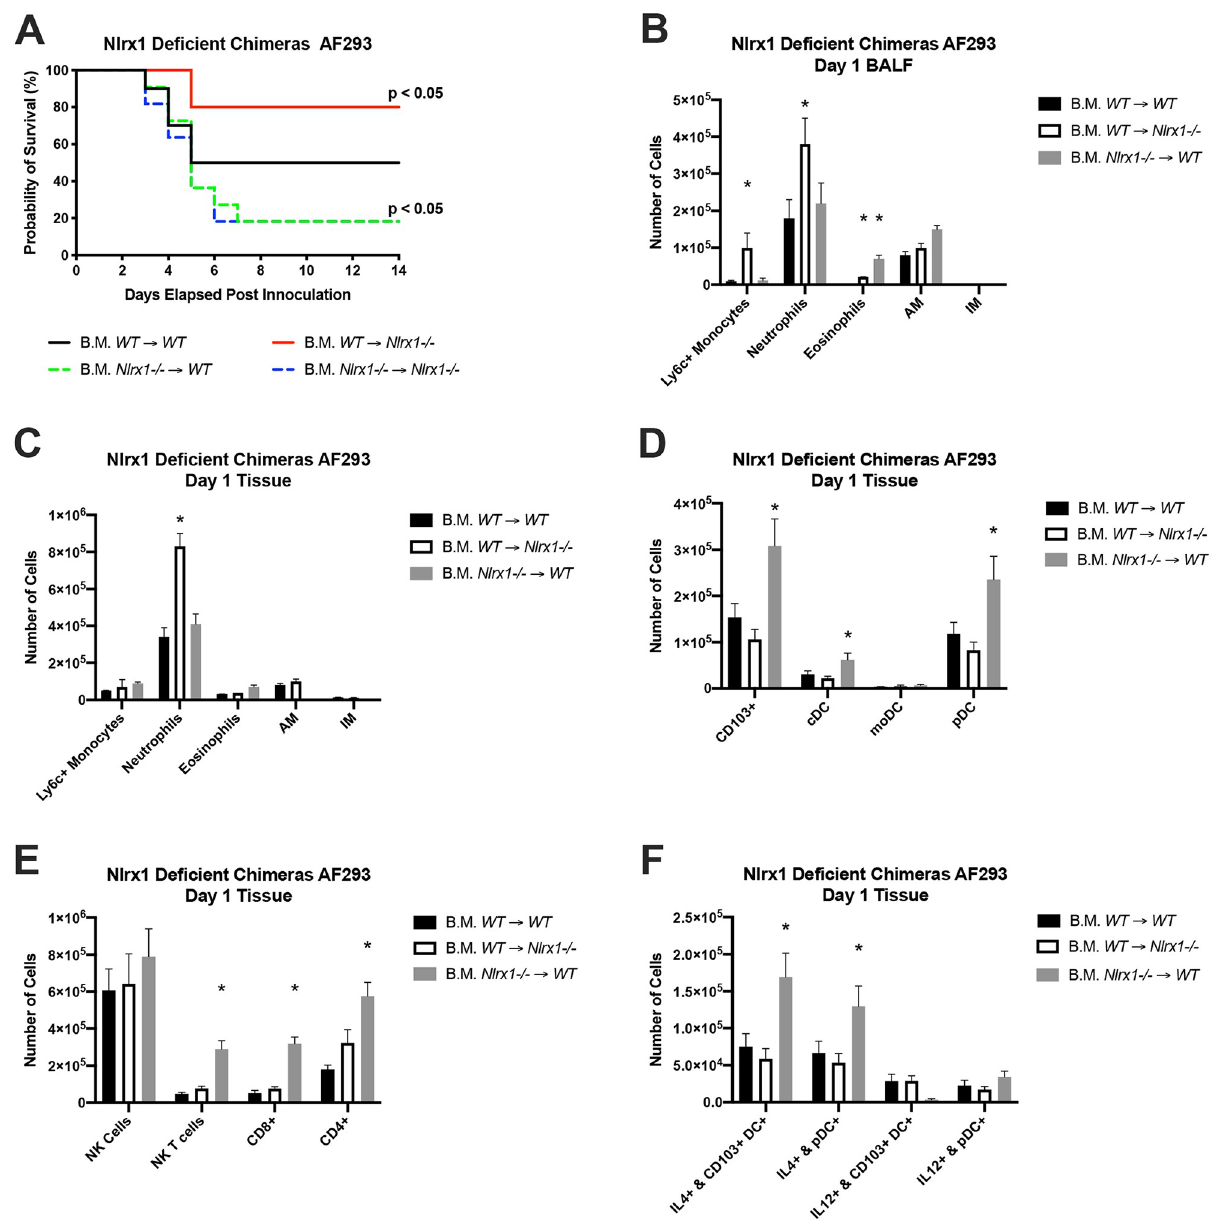
Fig 8. Loss of Nlrx1 in either radio-sensitive and insensitive cells populations impacts survival and immune cell recruitment. Wild type and Nlrx1-/- mice were irradiated and replenished with bone marrow from healthy wild type or Nlrx1-/- mice. Mice were allowed to recover for 6–8 weeks prior to inoculation. (A) Kaplan-Meier survival curve for neutrophil depleted chimeric mice inoculated with AF293 via non-invasive tracheal instillation AF293 conidia (10 7 conidia/ 25 μ L). Mice were immuno-suppressed on day 1 prior and day 3 post inoculation using IP injection of Ly6G antibody (Clone A18). Statistical significance was determined using the log-rank (Mantel-Cox) test. N = 10 experimental group. (B-F) FACS analysis of immune cell populations from bronchoalveolar lavage fluid BALF and pulmonary tissue from immuno-competent chimeric mice on day 1 post inoculation were determined by FACS. Asterisk denotes statistical significance, P < 0.05 Mann-Whitney U test. Error bars indicate standard deviation. N = 8–10 per experimental group. AM, alveolar macrophages. IM, interstitial macrophages. DC, dendritic cells. pDC, plasmocytoid dendritic cells. moDC, monocytoid dendritic cells. cDC, conventional dendritic cells. NK, natural killer cells. NKT, natural killer T cells. CD8+, CD8+ T cells. CD4+, CD4+ T